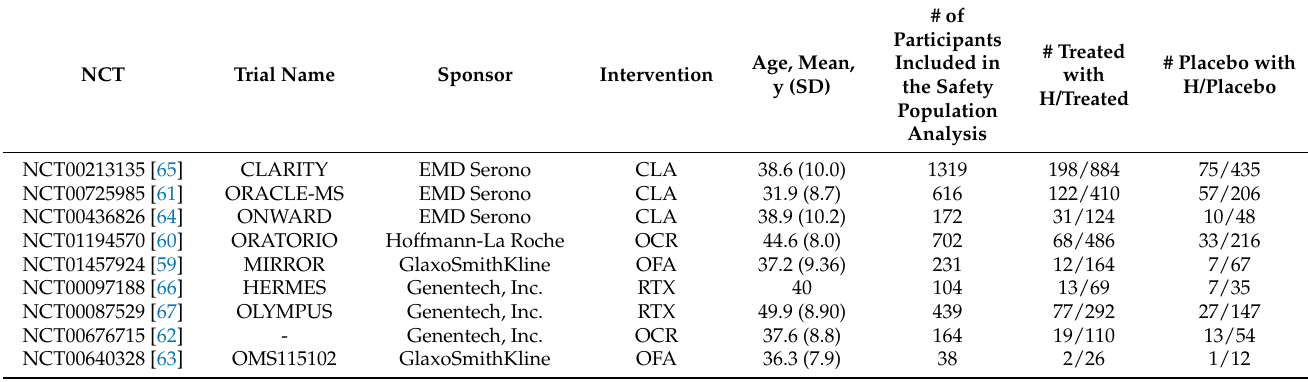
Table 1. Main characteristics of the included